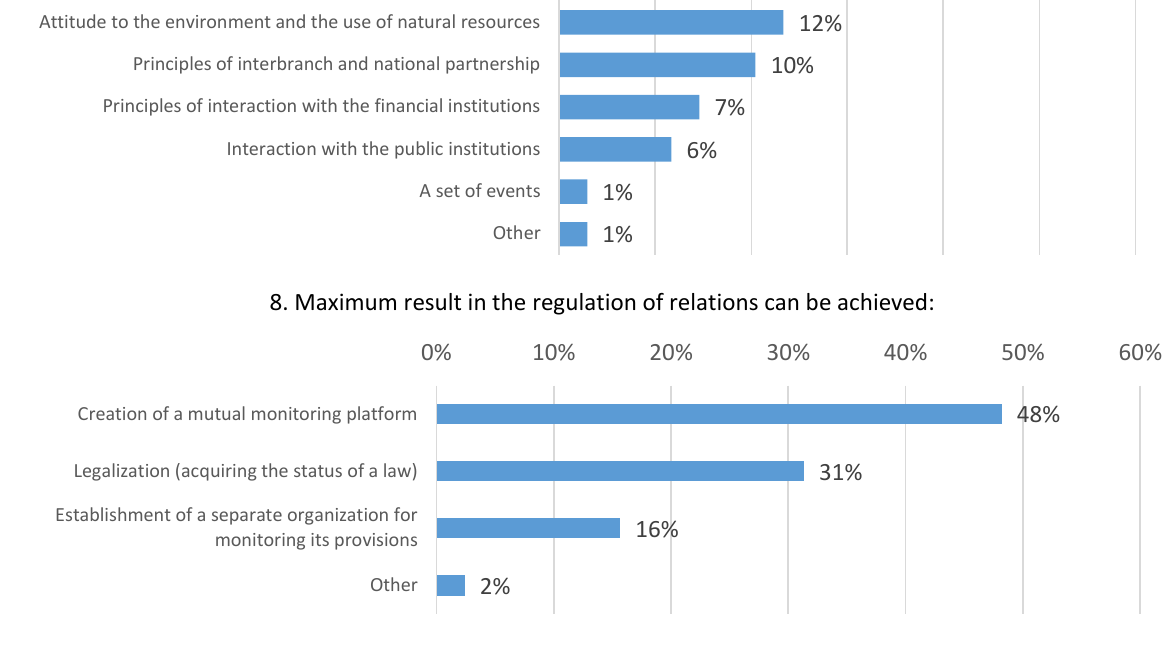
Figure 6. Structural indicators of answers to questions that determine the relevance and significance of the Code modules,